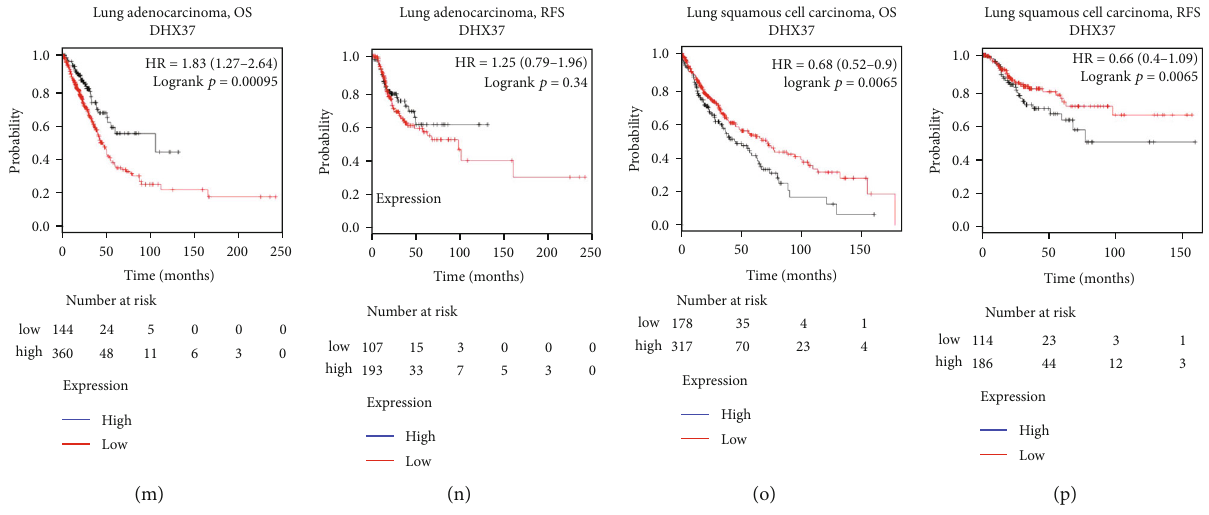
Figure 2: Kaplan-Meier survival curves comparing the high and low expression of DHX37 in di ff erent types of cancer in the PrognoScan (a – h) and Kaplan-Meier plotter databases (i – p). (a, b) Survival curves of RFS and OS in two lung cancer cohorts [GSE31210 ( n = 204 ) and GSE11117 ( n = 41 )]. (c, d) Survival curves of DFS and OS in colorectal cancer cohort (GSE17536, n = 145 ) and skin cancer cohort (GSE19234, n = 38 ). (e, f) Survival curves of OS and DSS in two blood cancer cohorts [GSE12417-GPL570 ( n = 79 ) and GSE2658 ( n = 559 )]. (g, h) Survival curves of DMSF and RFS in the breast cancer cohort (GSE6532-GPL570, n = 87 ). Kaplan-Meier survival curves comparing the high and low expression of DHX37 in Kaplan-Meier Plotter, OS, and RFS of (i, j) liver hepatocellular carcinoma (LIHC) (k, l) breast cancer (BRCA) (m, n) lung adenocarcinoma (LUAD) (o, p) lung squamous cell carcinoma (LUSC). Red curve represents patients with high expression of DHX37. OS: overall survival; DMSF: distant metastasis-free survival; DFS: disease-free survival; RFS: relapse-free survival; DSS: disease-speci fi c